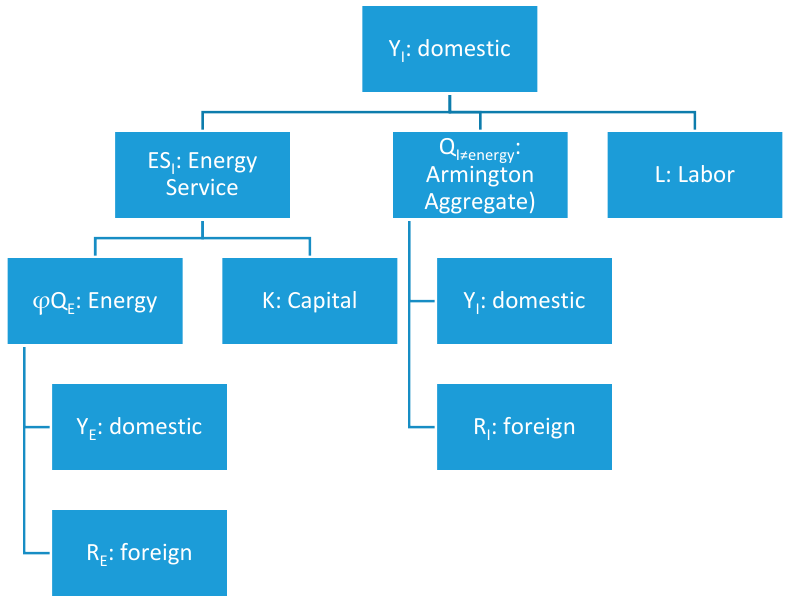
Figure 2. Structure of domestic production of goods and services.